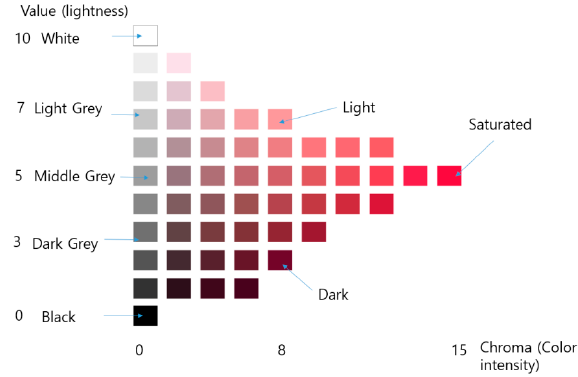
Figure 2. Saturated (S), light (L), and dark (D) for red.